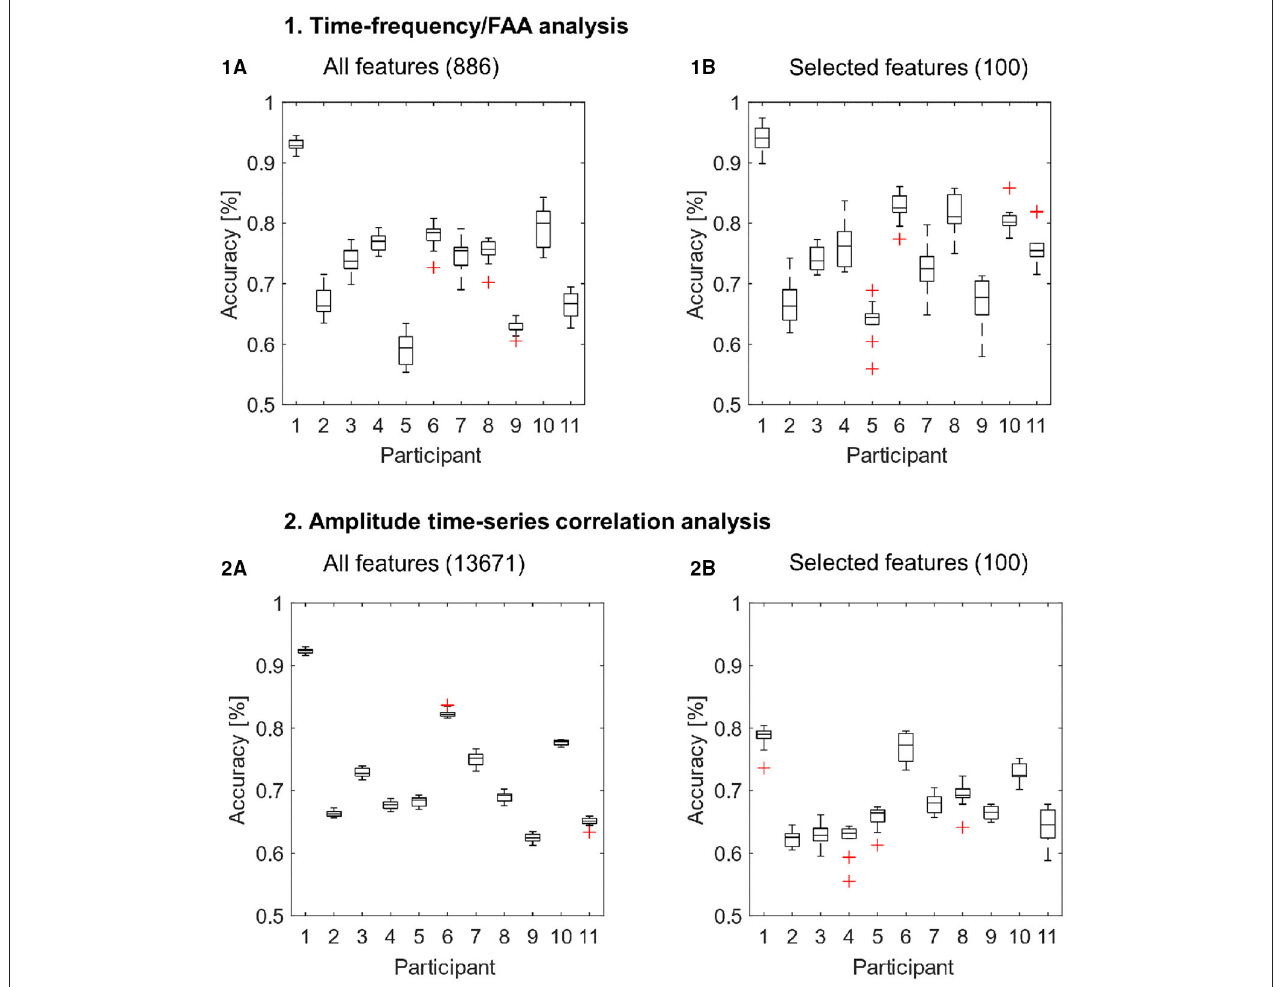
FIGURE 3 | Classification results for the features extracted with the time-frequency/FAA analysis (1A,1B) and amplitude time-series correlation analysis (2A,2B) . The classification was performed with all available features (1A,2A) and exclusively with the 100 selected features (1B,2B) for each feature extraction method. We performed eight-fold cross-validation ten times, such that the boxplots depict the results of 10 classification runs for each participant.